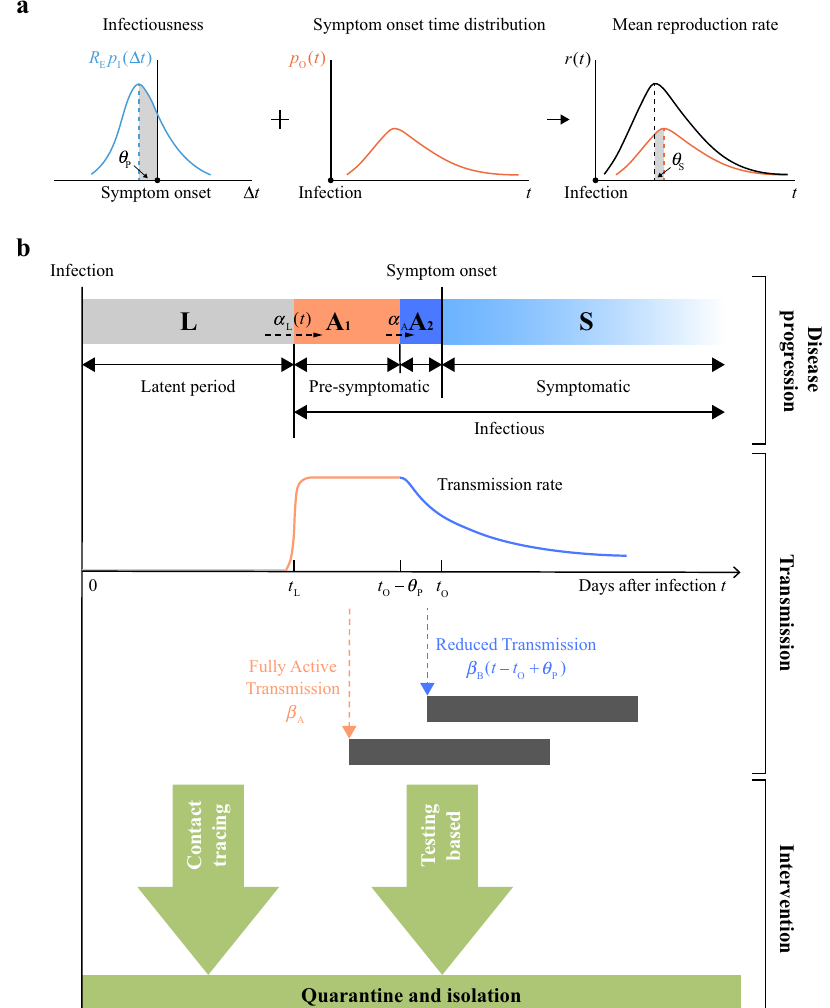
Fig. 1 A stochastic model for COVID-19 disease progression, transmission and intervention. a The mean reproduction rate r ( t ) (black curve) of a patient on day t since infection is expressed as a convolution of the symptom onset time distribution p O ( t ) (red curve) and the infectiousness curve R E p I ( Δ t ) (blue curve), where Δ t is measured from the symptom onset. The mean reproduction number R E sets the overall level of the epidemic. The peak of the normalised infectiousness function p I ( Δ t ) is shifted from the symptom onset by an amount θ P , which takes a positive value on the pre-symptomatic side. The peak of the mean reproduction rate r ( t ) is shifted from the peak of the symptom onset time distribution p O ( t ) by θ S . b A compartmentalised model. A person infected fi rst goes through a non-infectious latent phase (L) until t L , followed by an infectious period that spans across symptom onset at t O . In the pre-symptomatic phase A, the person is infectious without symptoms. The A phase is further split into two subphases, A 1 with a constant transmission rate (orange region) and A 2 with a declining transmission rate (blue region). At the symptom onset time t O , the person enters the S phase, and continues to be infectious (light blue region). Contact tracing brings an infected person out of the transmission cycle at the point of isolation, while testing does so only when the result is